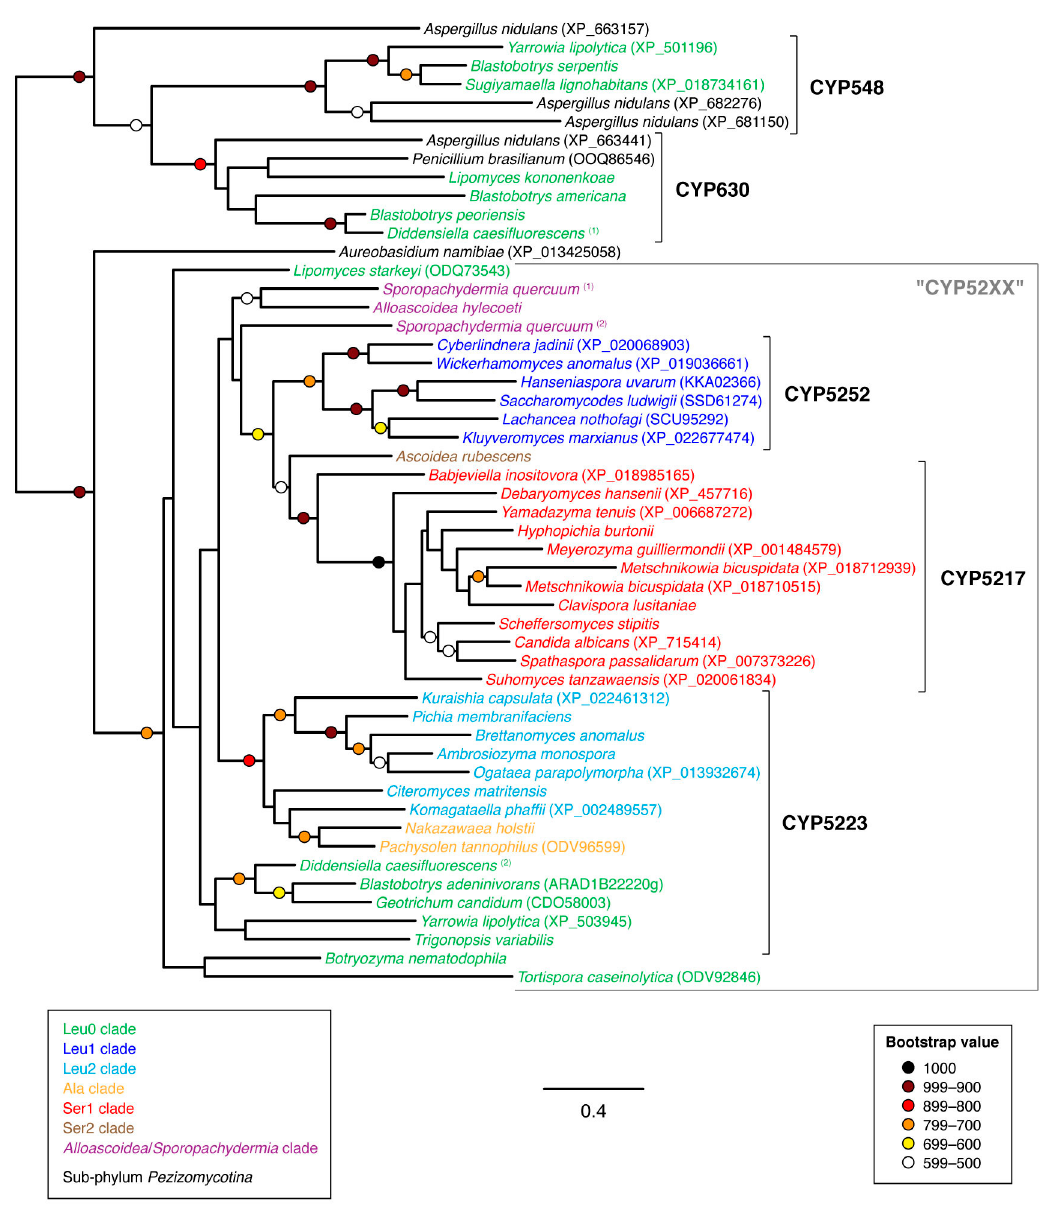
Figure 8. Unrooted phylogram of CYP548, CYP630, CYP5217, CYP5223, CYP5252 and associated gene products in representative species of sub-phylum Saccharomycotina as well as selected non- Saccharomycotina species. Individual species are color-coded with respect to clade [24]. The analysis was based on 217 aligned amino acid positions of the corresponding proteins. Colored circles represent branch support with the color indicating the proportion of retained nodes among 1000 bootstrap replicates. Branches lacking circles indicate branch support less than 500. Accession numbers for individual protein sequences are displayed when available. Protein sequences lacking accession numbers were derived through conceptual translation of genomic sequences. (Genomic coordinates for protein sequences derived through conceptual translation of genomic sequences are listed in Table A1 of Appendix A.).